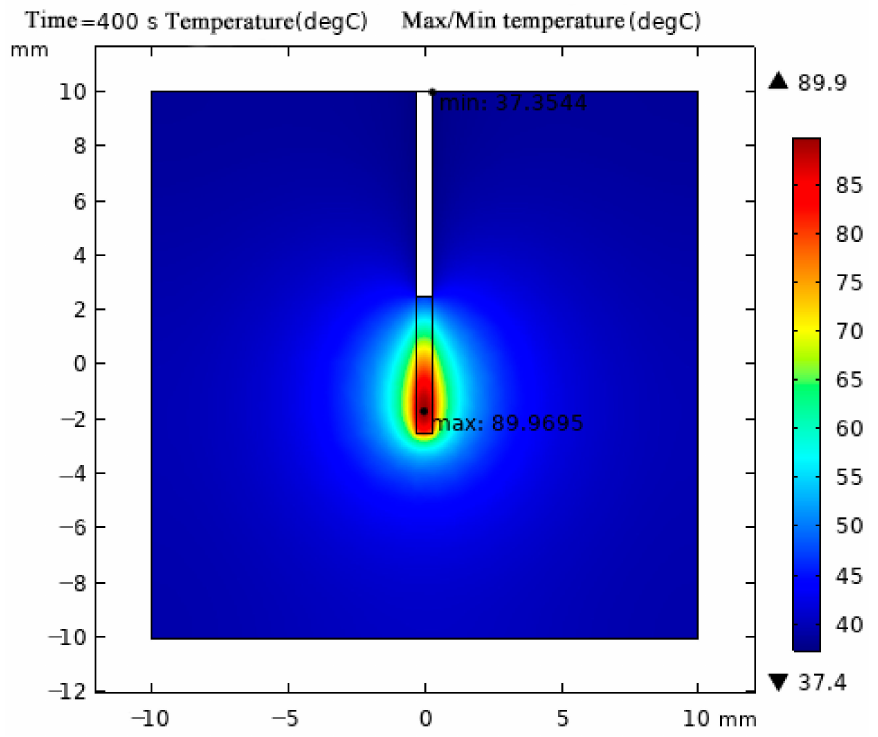
Figure 4. PID control LITT temperature distribution